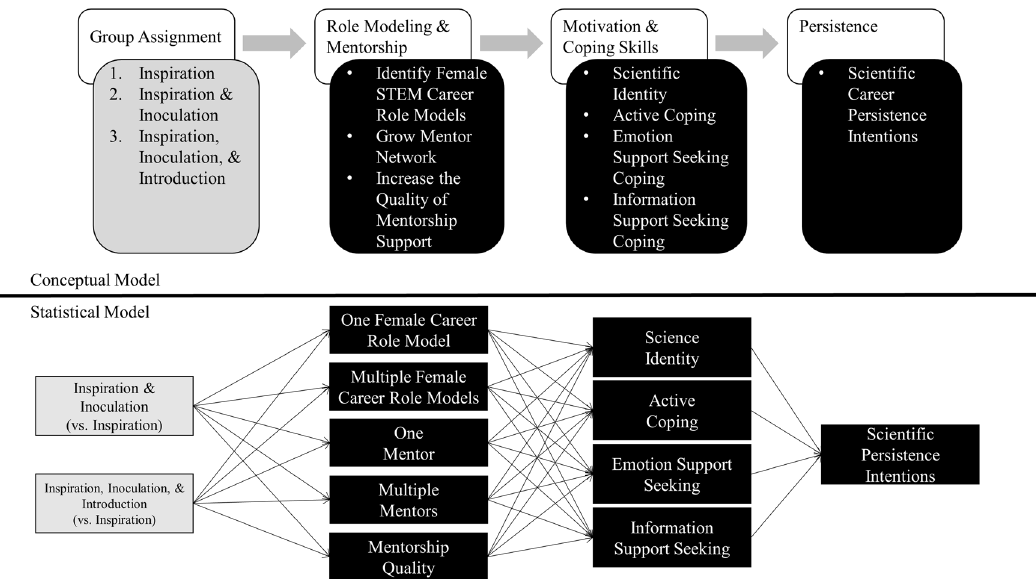
Fig. 1 Experimental process model linking group assignment (gray box) to impacts (black boxes) on persistence through role modeling, mentoring, motivation, and coping skills. Notes: Conceptual model: students were randomly assigned to one of the three experimental groups emphasizing (1) Inspiration (2), Inspiration & Inoculation, or (3) Inspiration, Inoculation, & Introductions. We measured and compared the identi fi cation of female STEM career role models (0, 1, or multiple female role models), mentor network size (0, 1, or multiple mentors), the quality of mentorship support received, science identity (motivation), and coping skills between groups, as well as their persistence intentions. Statistical model: group assignment, posttest role models, and posttest mentors were recoded for analysis, such that each is treated as a binary variable. A number of regression paths are not shown for the sake of parsimony, such that the paths are linking (a) group assignment to motivation & coping skills and to persistence, (b) role modeling and mentorship to persistence, and (c) pretest role modeling & mentorship, motivation & coping skills, and persistence to their posttest